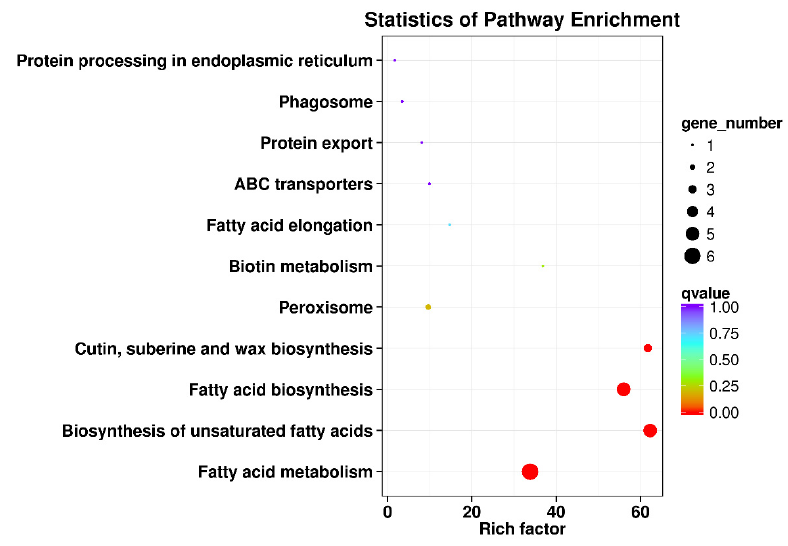
Figure 4. KEGG pathway enrichment of differentially expressed genes (DEGs) associated with Achnatherum inebrians according to the status of Epichloë endophytes and in different growing periods. The q-value ranges from 0 to 1, and a q-value closer to 0 indicates greater enrichment.